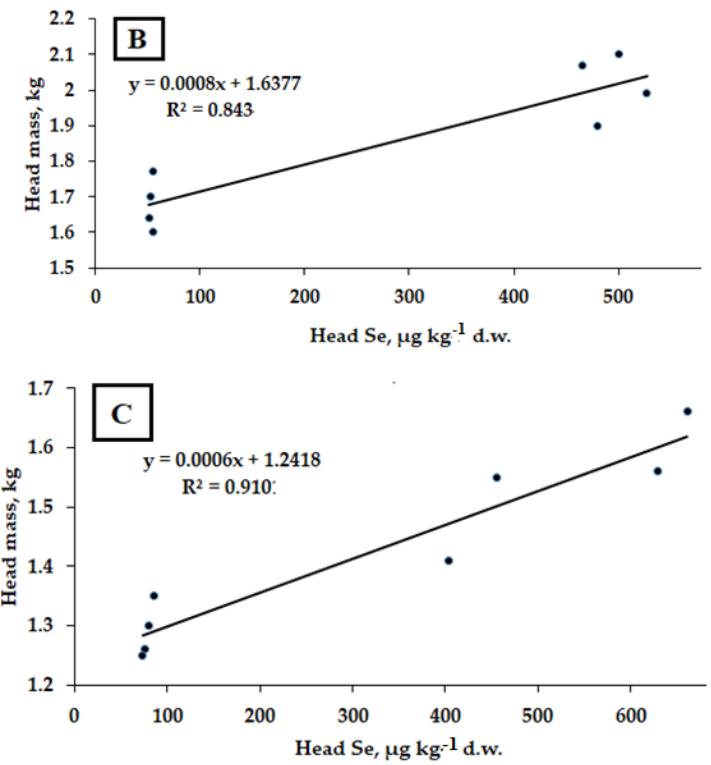
Figure 4. Correlation between head Se levels and weight of Savoy cabbage treated with sodium selenate and Chlorella . ( A ): Vertu 1430 (r = 0.897; p < 0.001); ( B ): Golubtsy (r = 0.918; p < 0.001); ( C ): Melissa (r = 0.954; p < 0.001).